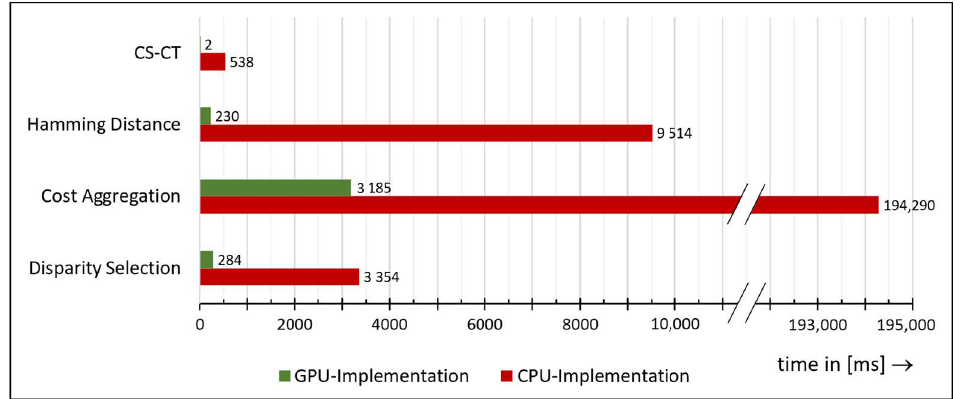
Figure 18. Runtime comparison of the single algorithms of the Semi-Global Matching (SGM) pipe- line.